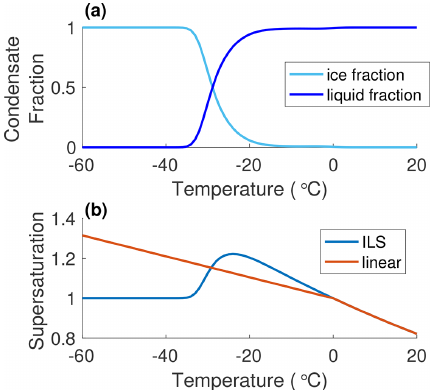
Figure A7. Supersaturation of vapor over ice. (a) Fractions of ice (cyan) and liquid (blue) condensate as a function of temperature. Curves are derived from satellite-based measurements (Hu et al., 2010). (b) Supersaturation as a function of temperature. The blue curve shows supersaturation based solely on the saturated vapor pressures of ice and liquid, the mixing fractions based on the curves shown in panel (a) , and the pseudo-adiabatic assumption (ILS). The red curve shows the linear parameterization of supersaturation (lin- ear) used in the model, S i = 1 − 0 . 00525 ◦ C − 1 × T . Note that the atmosphere is subsaturated with respect to ice at temperatures above 0 ◦ C but that our pathways do not include ice at these